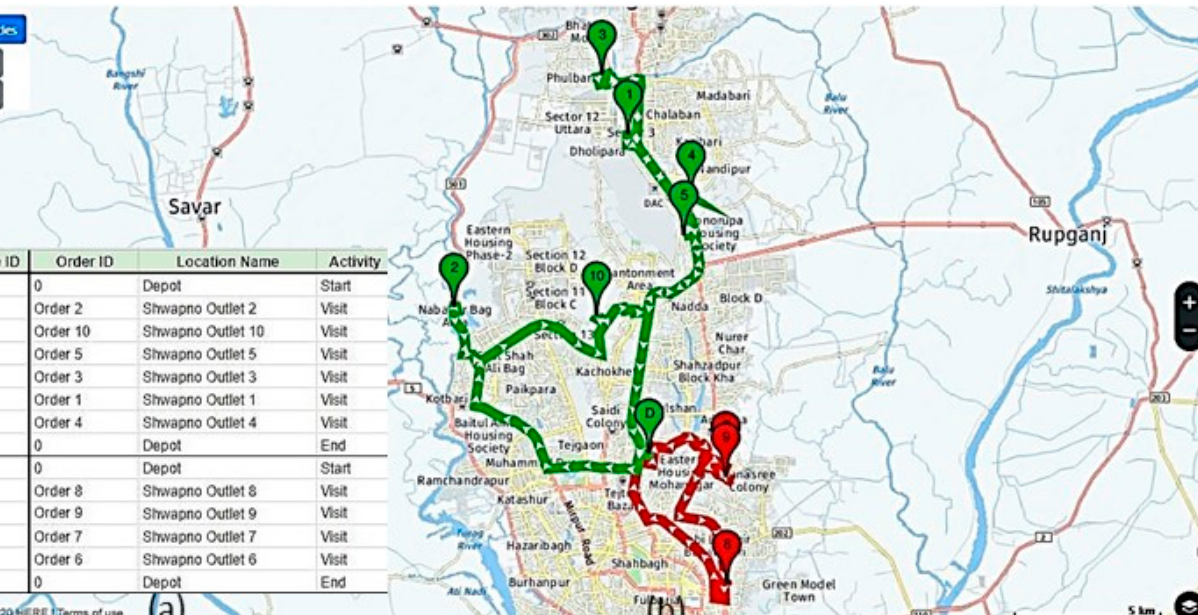
Figure 7. ( a ) Scheduling ( b ) Navigation sequencing of vehicles 3 and 4 in Region-2.